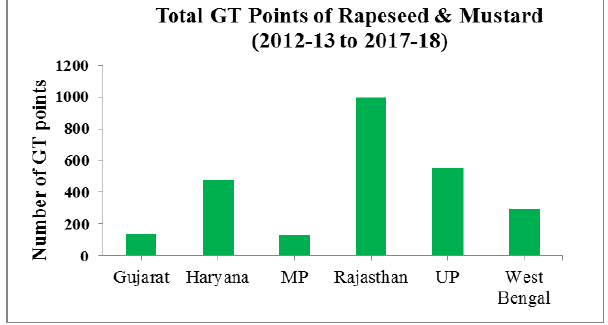
Figure 4. State-wise GT points of Rapeseed & Mustard (2012-